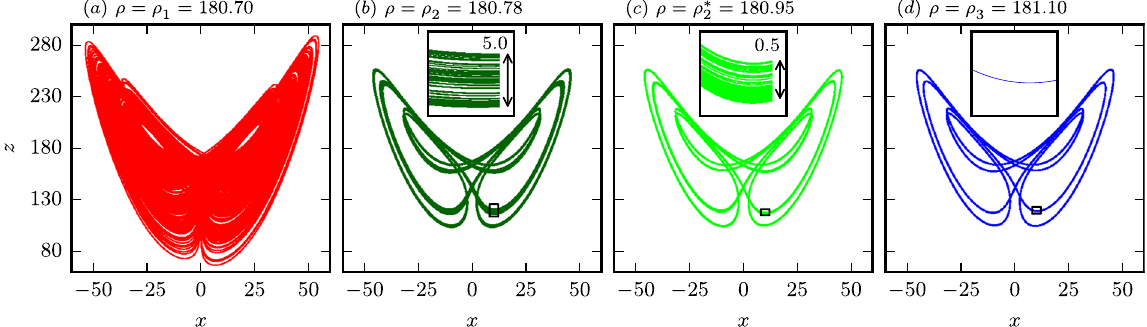
Figure 2. Sample trajectories of the Lorenz system (1) projected to the x − z plane. The phases, from left to right, ρ = ρ 1 (ergodic motion), ρ = ρ 2 and ρ ρ = ⁎ (partially predictable chaos) and ρ = ρ 3 (limit cycle), are 2 indicated in Fig. 1. The arrows in the respective insets indicate the width of the (fractal) braids in the partially predictable phase. The respective standard deviations s of the attractors are s ∈ [58.76, 58.92] for ρ ∈ [ ρ 1 , ρ 3 ].